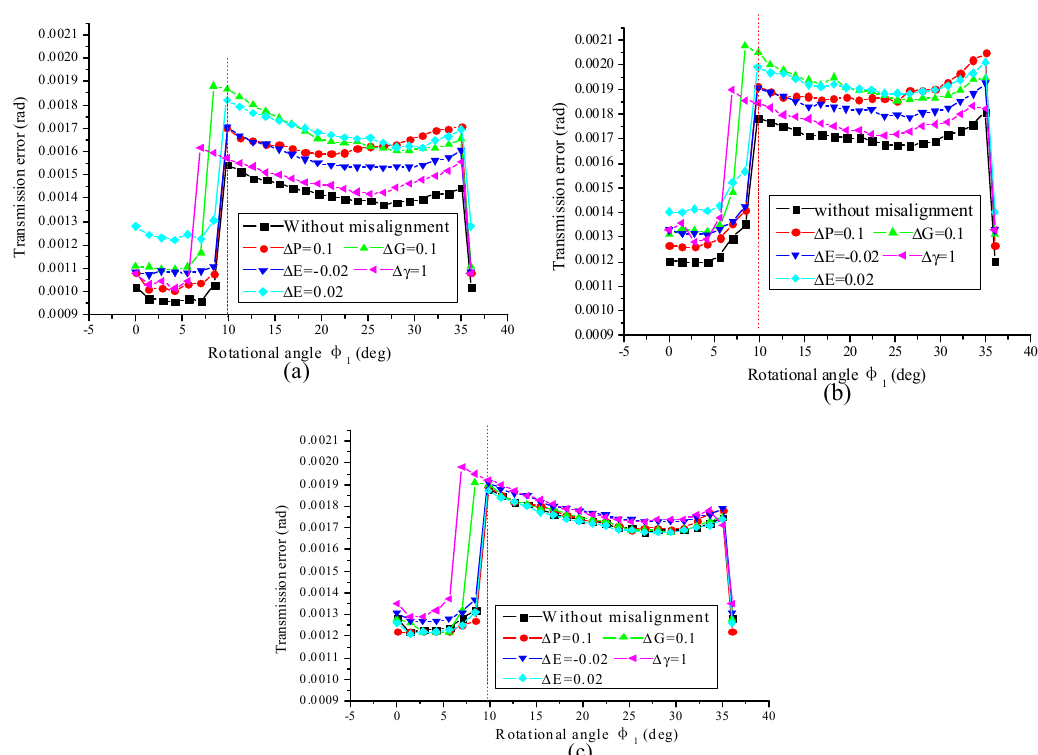
Figure 21. Variation of transmission errors of driving pinion in different installment conditions—( a ) no modification, ( b ) tooth end relief (Case4) and ( c ) symmetric crowned modification (Case1).